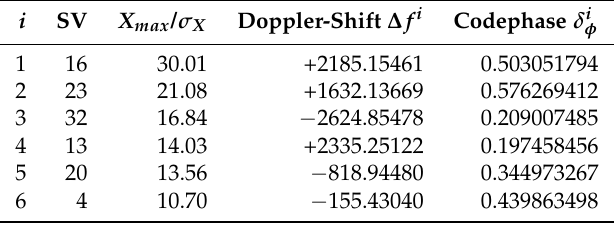
Table 1. Typical acquisition results for a 4 ms sample of signal (shown in Figure 1). There are six satellite signals that exceed the threshold set for signal detection in this data. i SV X max / σ